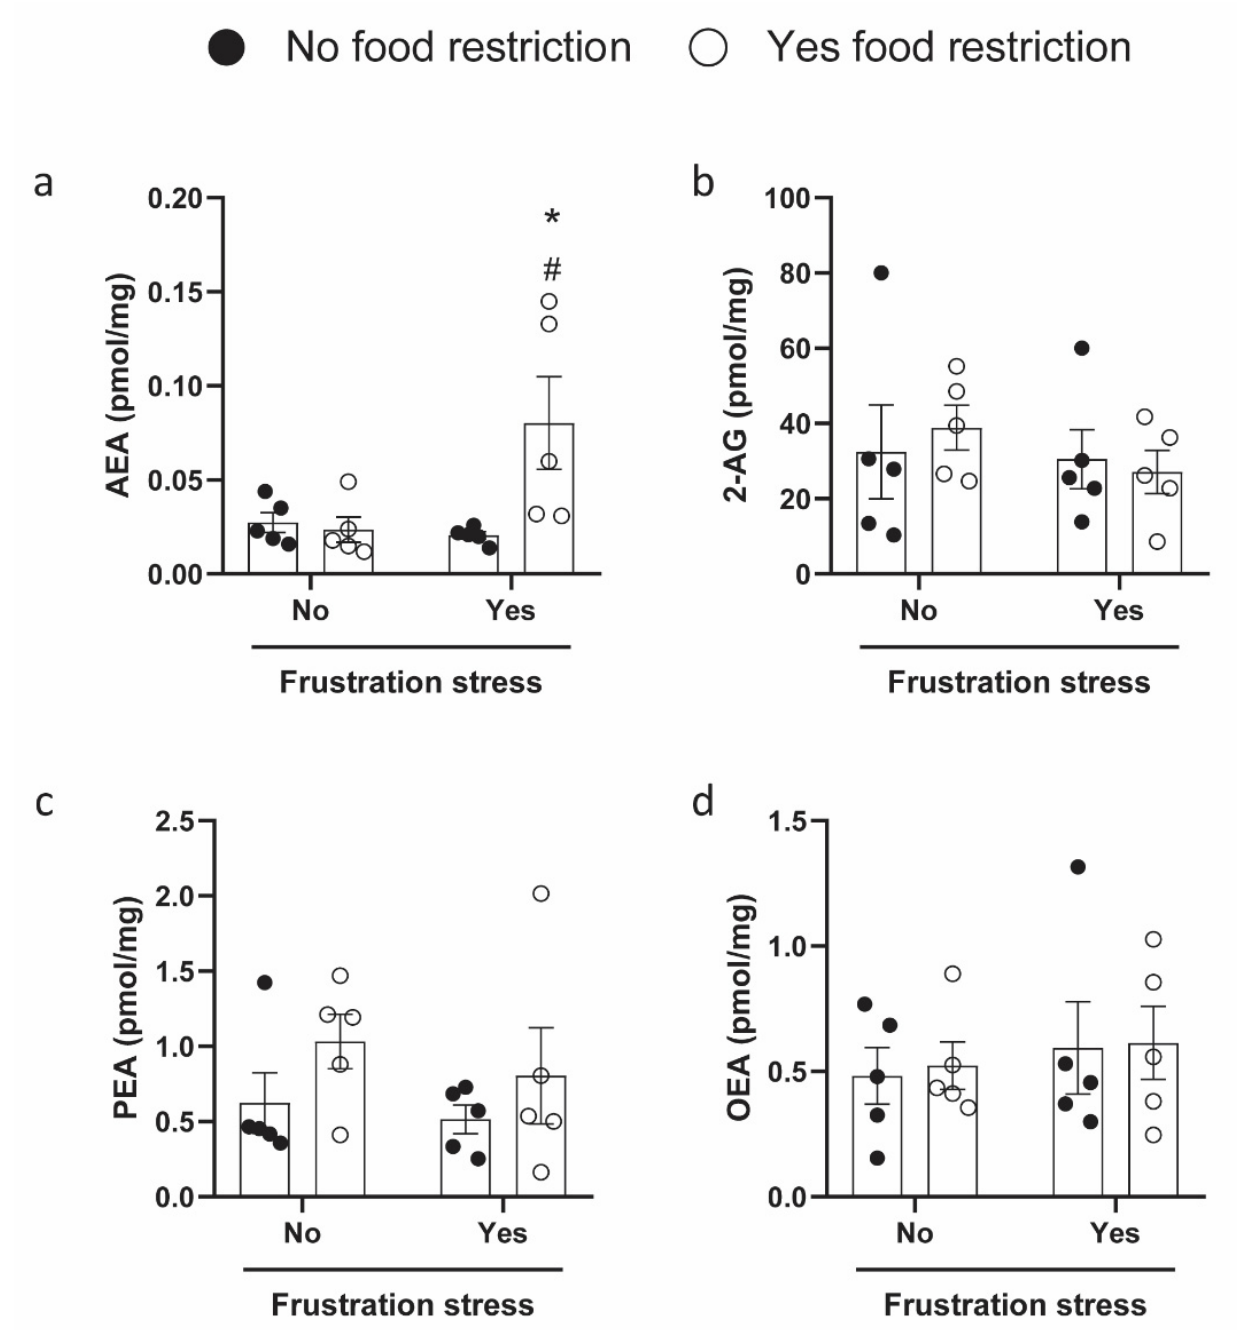
Figure 5. Endogenous levels of eCBs (( a ) AEA, Anandamide; ( b ) 2-AG, 2-arachidonoylglycerol; ( c ) PEA, N-palmitoylethanolamine and ( d ) OEA, N-oleoylethanolamide) in the hypothalamic region of rats exposed or not to BE protocol. Data were expressed as means ± SEM, n = 5 per group. Data were analyzed by two-way ANOVA in a 2 (food restriction: no, yes) × 2 (frustration stress during testing: no, yes) factorial design. Bonferroni’s post hoc tests were used to follow up on significant interaction or main effects ( p < 0.05) from the factorial ANOVAs. Significant differences are indicated: # p < 0.05 versus R + NS, * p < 0.05 versus NR +